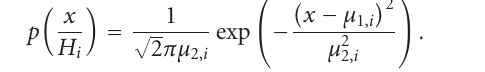
Figure 1: Proposed modulation identification